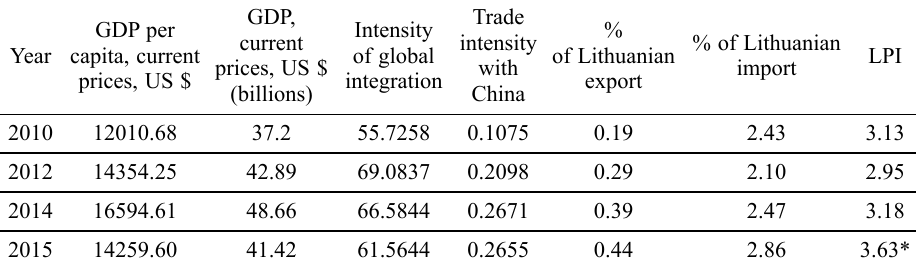
Table 2. Evaluation of the potential of Lithuania as a participant of the